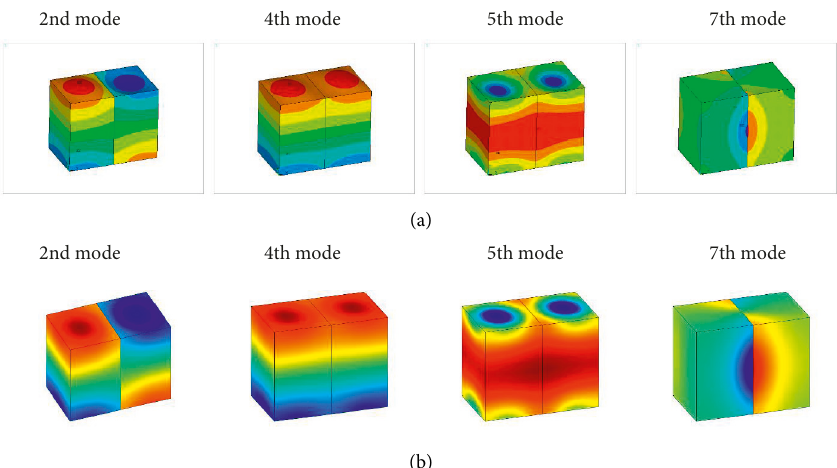
Figure 5: Some sound pressure mode shapes of two acoustic cavities in the stiffened double panel-cavity coupled system: (a) results from ANSYS and (b) results from the current method.